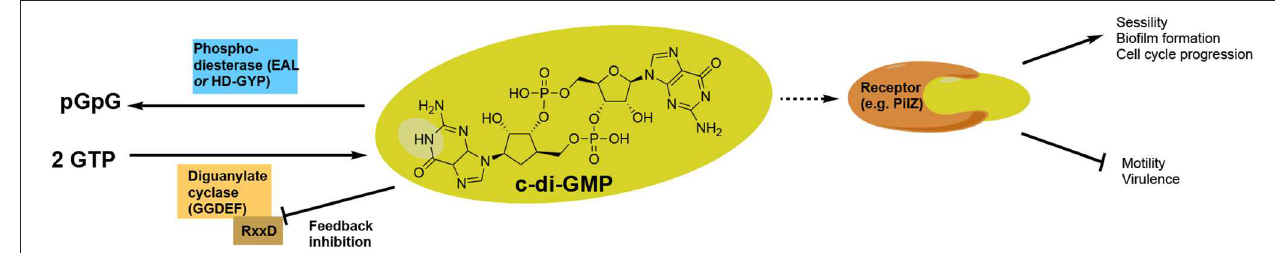
FIGURE 4 | Graphical illustration of c-di-GMP